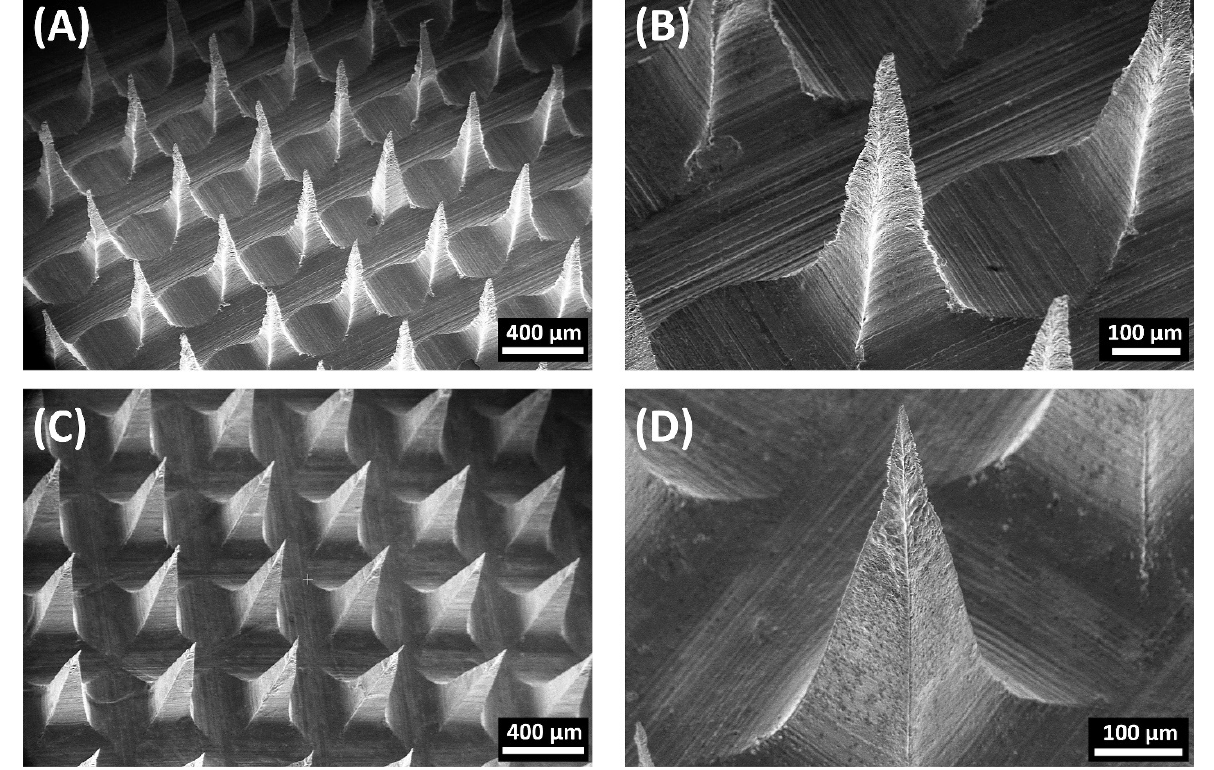
Figure 6. Representative SEM images of the obtained microneedles: ( A ) SA-MNs, ( B ) Close-up view of SA-MNs, ( C ) NP-MNs, and ( D ) Close-up view of